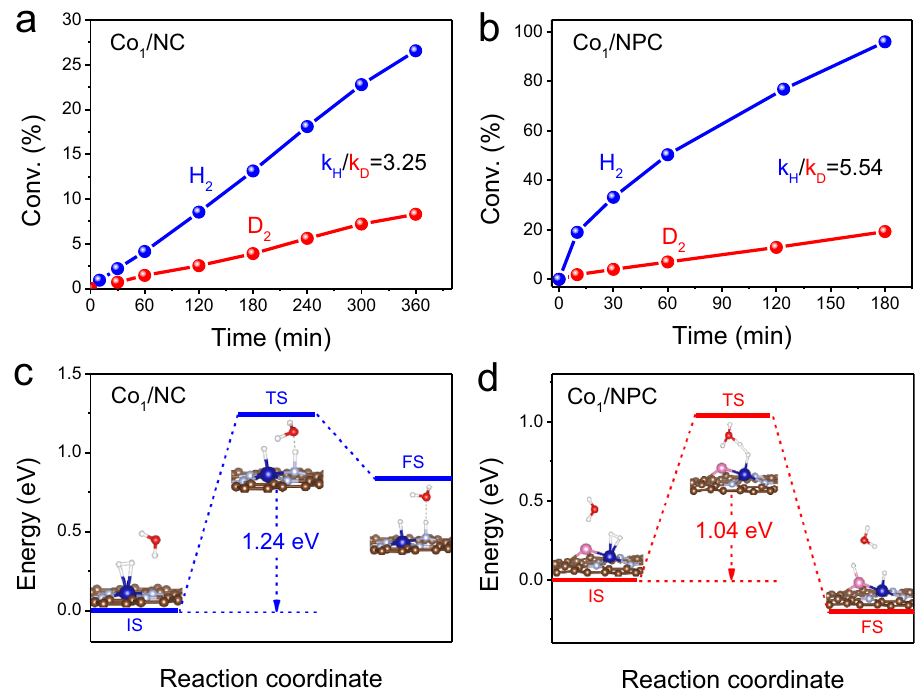
Fig. 4 Catalytic mechanism for the hydrogenation of nitrobenzene. Primary isotope effect observed on a Co 1 /NC and b Co 1 /NPC. Reaction conditions: 5 mg catalyst, 2 mmol nitrobenzene, 40 mL EtOH/H 2 O (D 2 O) (v:v = 4:1), 110 °C, 3 MPa H 2 (D 2 ). Energies pro fi les for H 2 dissociation pathways of c Co 1 / NC and d Co 1 /NPC samples. IS initial state, TS transition state, FS fi nal